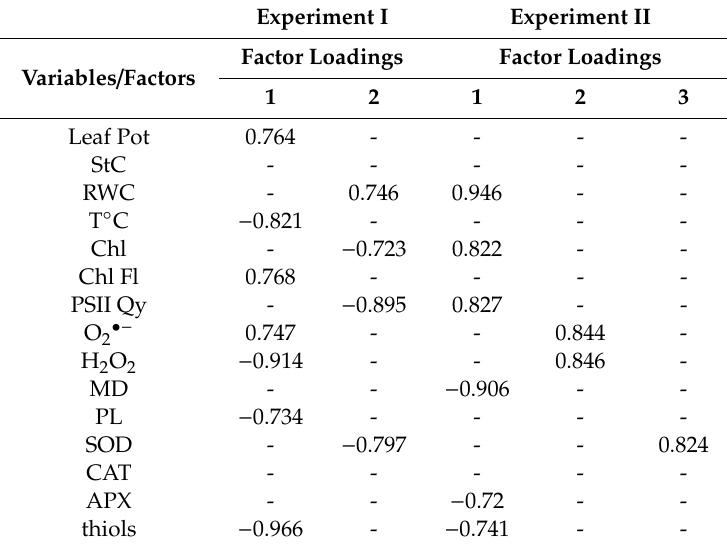
Table 14. Factor loadings of each variable of the two experiments.